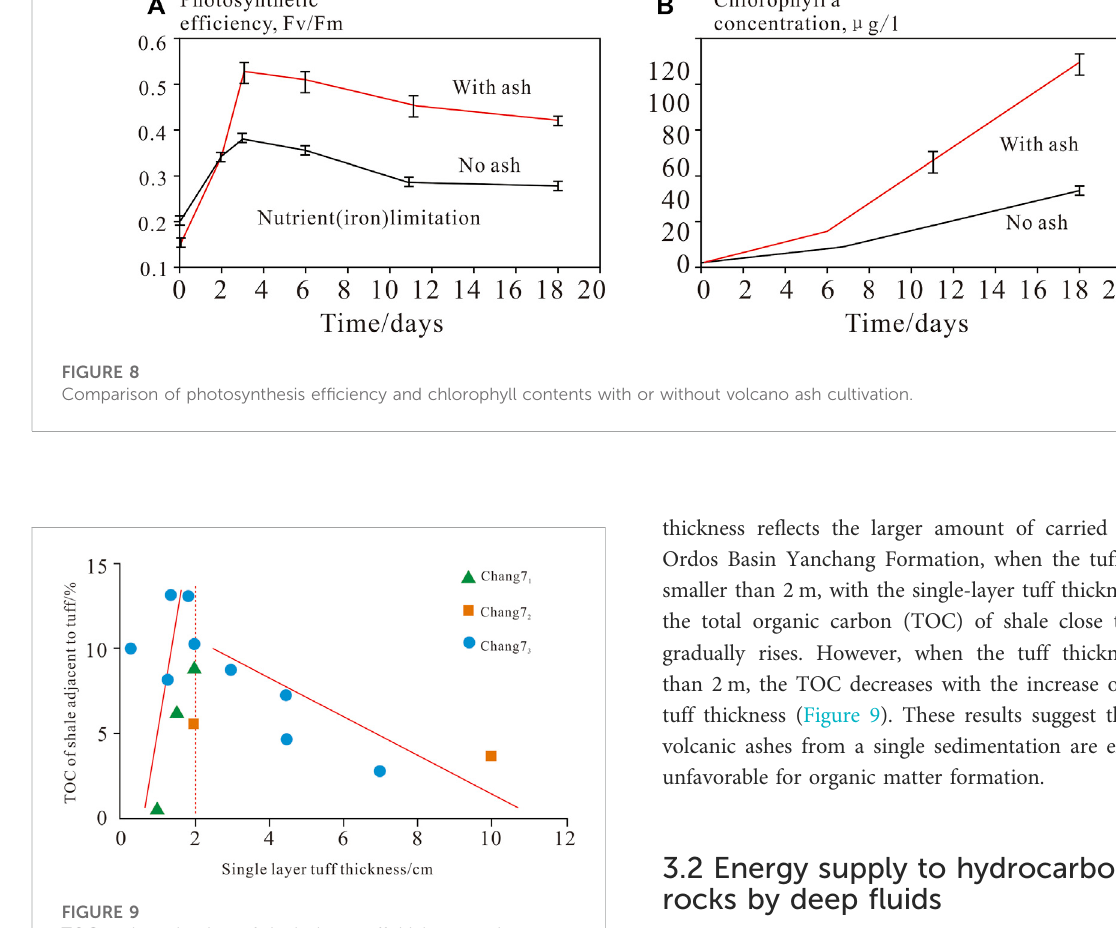
FIGURE 9 TOC projected points of single-layer tuff thickness and adjacent